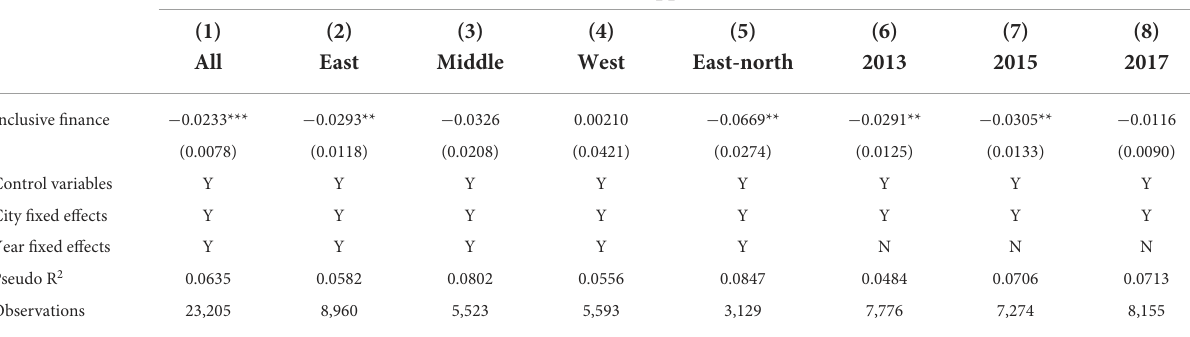
TABLE 5 Regression results of the impact of financial inclusion on